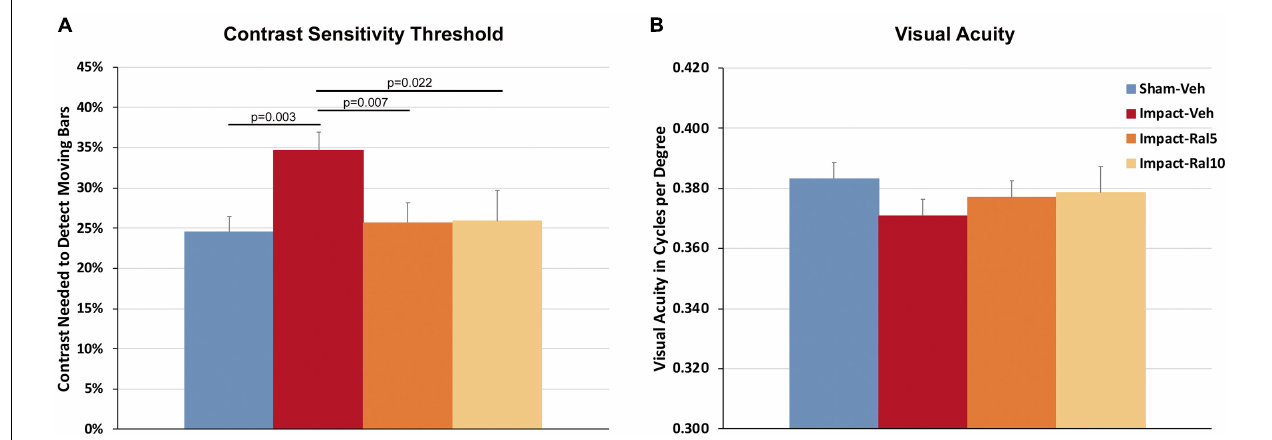
FIGURE 1 | Contrast sensitivity and visual acuity as measured using Optometry ∼ 2 months after impact. (A) The contrast sensitivity thresholds for both eyes were significantly higher in impact-vehicle mice than in sham-vehicle mice. Mice treated with raloxifene were similar to sham and improved over impact-vehicle mice. (B) Visual acuity for impact-vehicle mice was somewhat diminished compared to sham mice, but the reduction was not statistically significant. Mice treated with raloxifene showed a smaller reduction in visual acuity than the impact-vehicle mice. Data are pooled for the two eyes. Errors bars are SEMs. Animal numbers: 21 sham-vehicle mice, 26 impact-vehicle mice, 22 impact-ral5 mice, and 14 impact-ral10 mice.